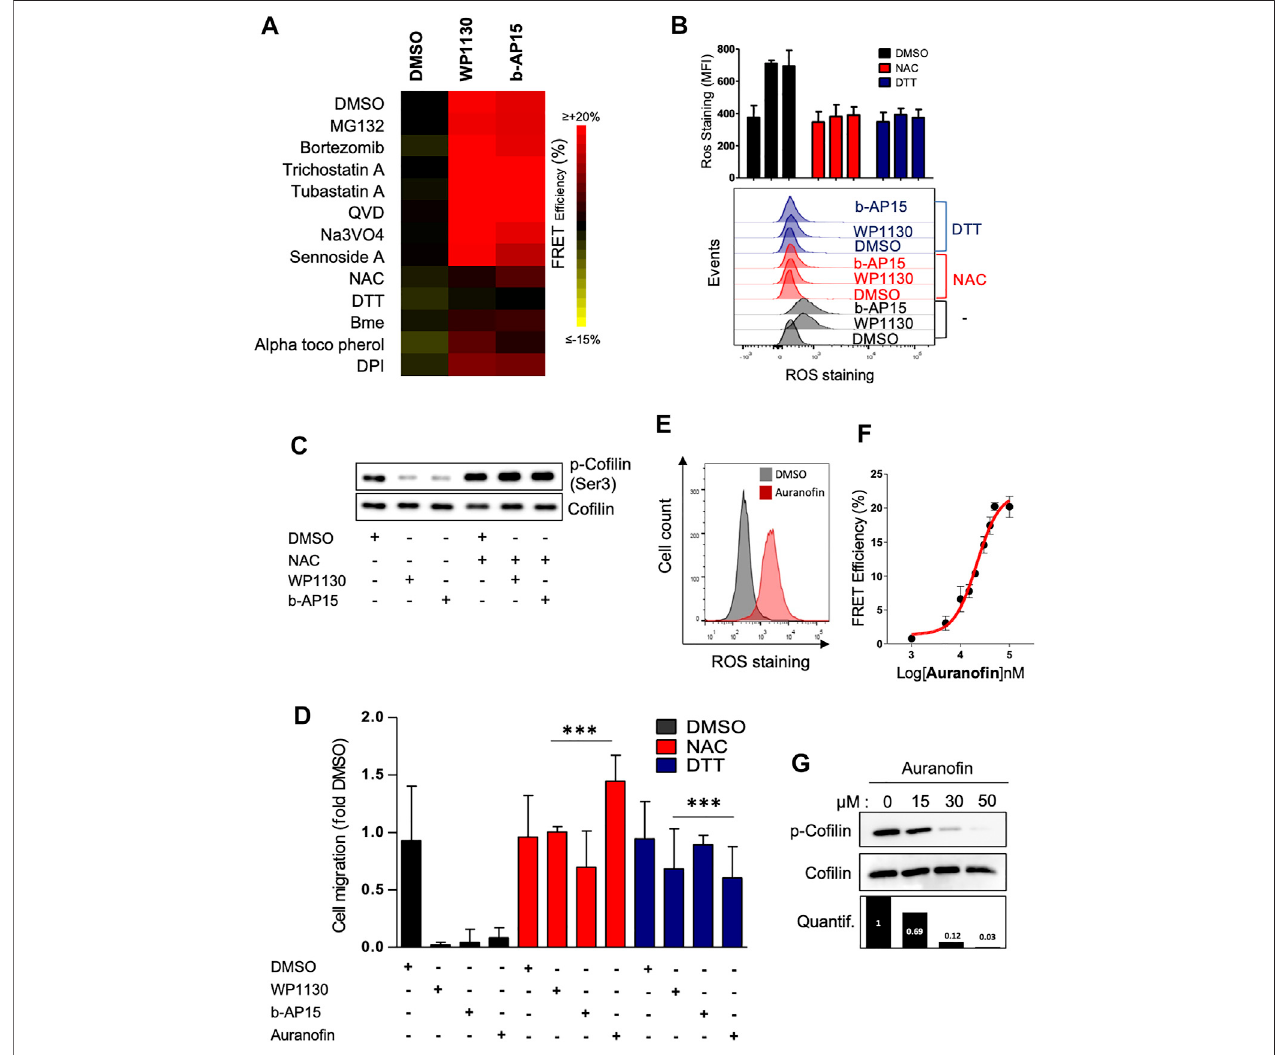
FIGURE 5| Actin cytoskeleton reorganization induced by WP1130 and b-AP15 isROS dependent. (A) Heatmap representation of actin FRET ef fi ciencies on ACT reporter cells that have been pre-treated with the indicated compounds, following exposure to 15 µM WP1130 or b-AP15 for 60 min. FRET signals were recorded by fl ow cytometry. Data are expressed as the percentage of FRET ef fi ciency between DMSO-treated and compound-treated cells and are representative of n (cid:2) 3 independent experiments. (B) Effect of WP1130 and b-AP15on ROS production. ACT reportercells that have been pre-treated with 1 mM DTT and 100 µM NAC were incubated with 15 µM WP1130 or b-AP15 for 60 min. Following treatment, cells were stained with 5 µM CM-H 2 DCFDA and analyzed by fl ow cytometry. Bar graphs show the mean fl uorescence intensity (MFI) of ROS staining of n (cid:2) 3 independent experiments. (C) Whole cell lysates of Jurkat pre-treated with 100 µM NAC beforeadditionornotof15 µMWP1130orb-AP15for30 minwereanalyzedbyimmunoblottingwithantibodiesagainstphosphorylatedco fi linandtotalco fi lin. (D) Effect of WP1130, b-AP15 and Aurano fi n on chemotactic migration of leukemic cells pretreated or not with DTT and NAC. Cells were migrated against 100 ng/ml of CXCL12 for 90 min in thepresence or notof theindicatedcompound. Resultsare expressed as thefold ofcellmigration compared tothe DMSO condition. Bar graphsshow the meanof n (cid:2) 3independent experiments. *** p < 0.001,unpaired t -tests between DMSOand each treatedcondition. (E) Effect ofAurano fi nonROSproduction. (F) Dose response curve of the activity of Aurano fi n on actin FRET ef fi ciency. (G) Immunoblot analysis showing the effect of Aurano fi n on the phosphorylation of co fi lin at Ser3. Densitometric quanti fi cation against total co fi lin signal is shown (lower panel).